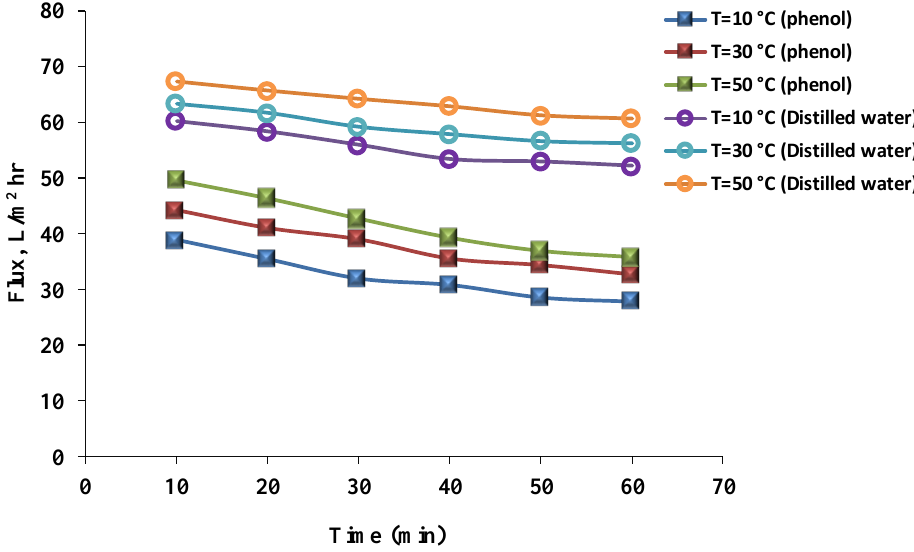
Figure 9. Phenol solution and distilled water’s fluxes with time using a hydrophilic membrane at different temperatures (pressure = 1 bar, phenol concentration = 50 mg/L).